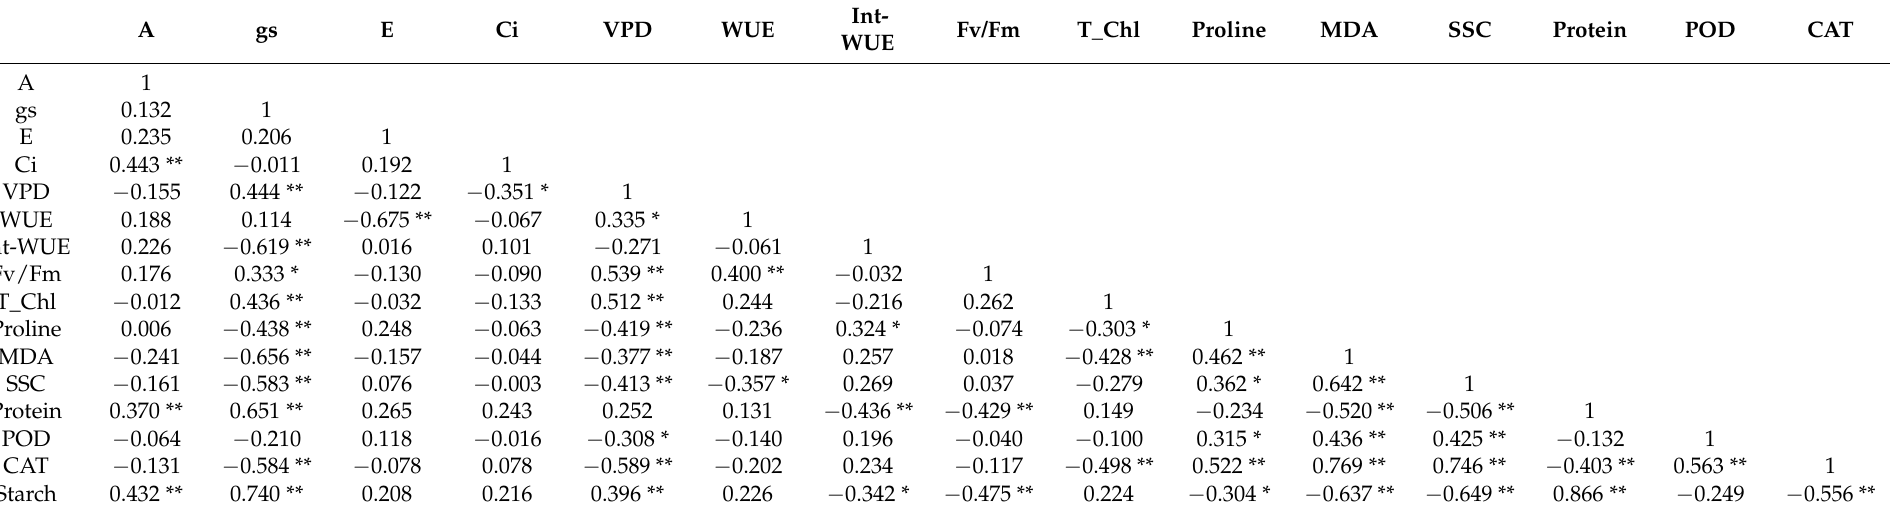
Table 1. Pearson correlation between all measured parameters in the experiment. * and ** indicate significant at p < 0.05 and 0.01,